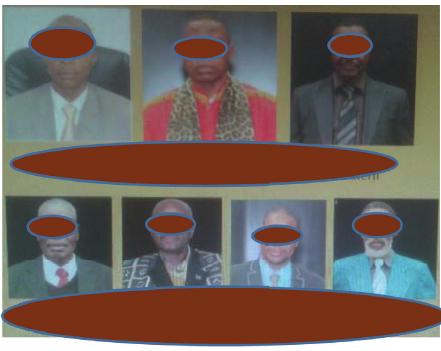
Figure 14: Traditional leadership: site one. Figure 15: Parents’ school support: site